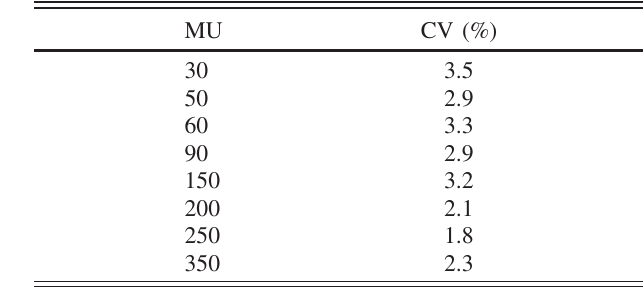
TABLE V. Output charge stability measurements.